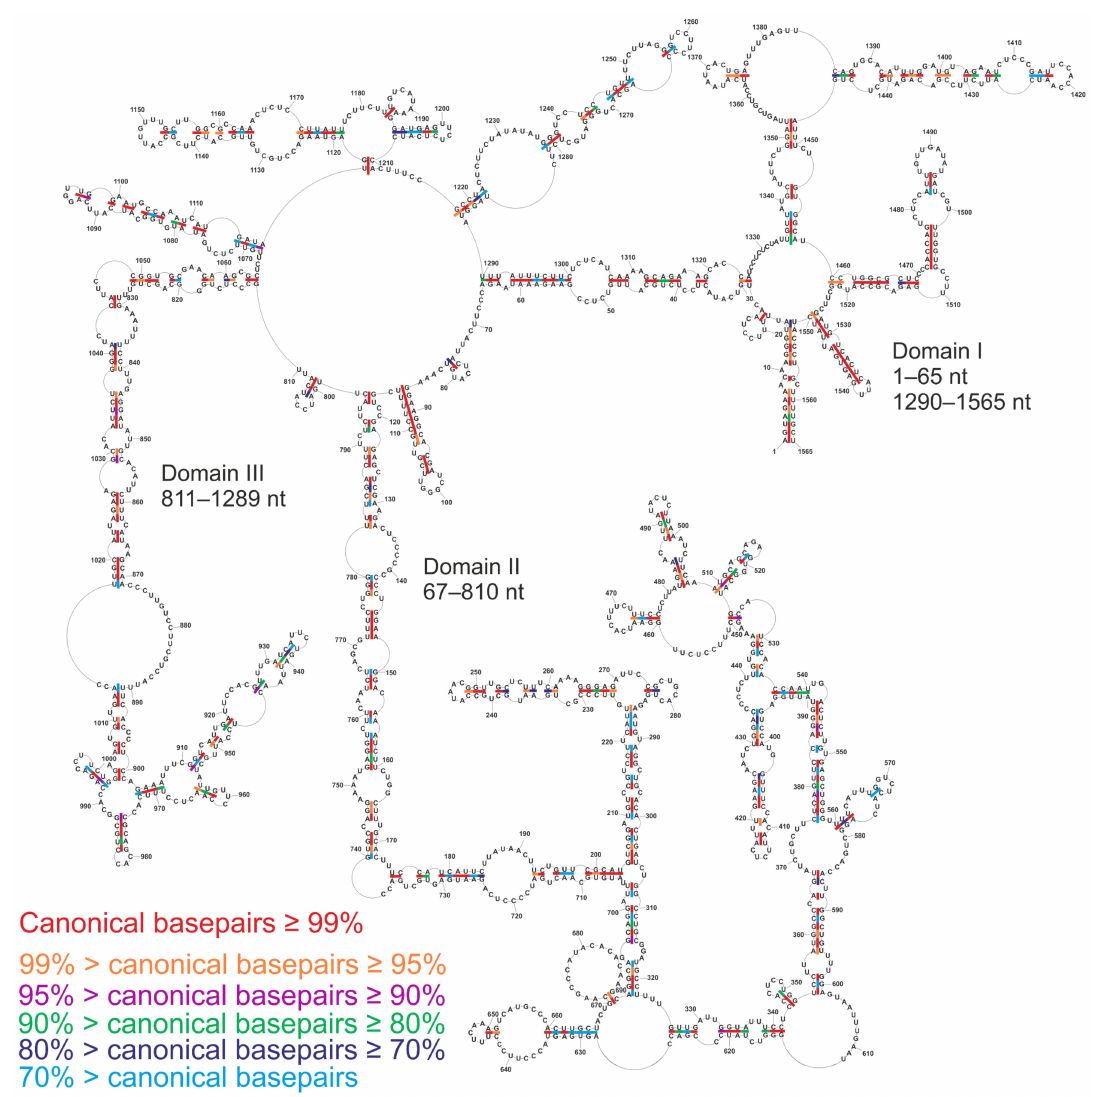
Figure 4. Conservation of determined vRNA5 secondary structure across influenza A viruses. Colors indicate percentage of canonical base pairing preserved among influenza A sequences for segment 5 vRNA. The analysis was done on 39,364